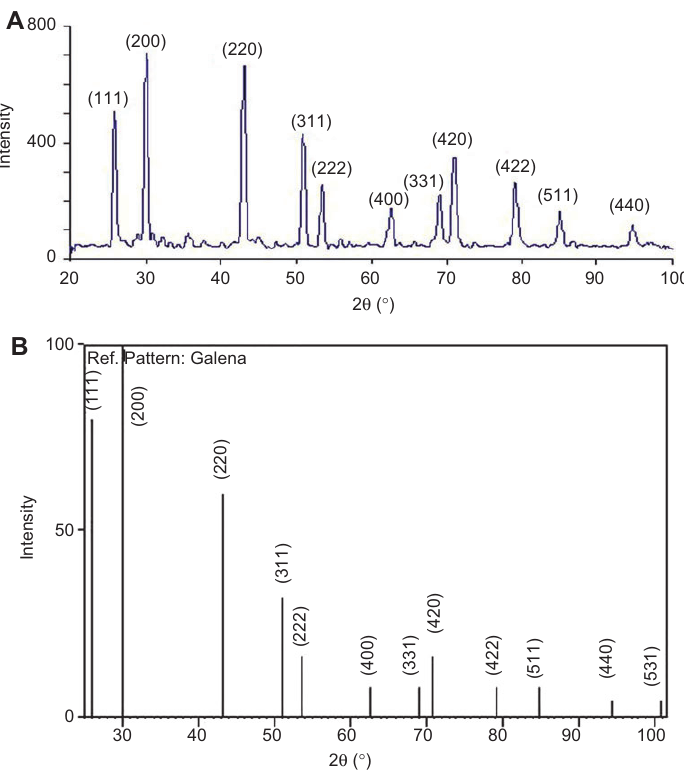
Figure 1 XRD pattern of the (A) obtained PbS with 1 m of thiophenol (B) standard peak